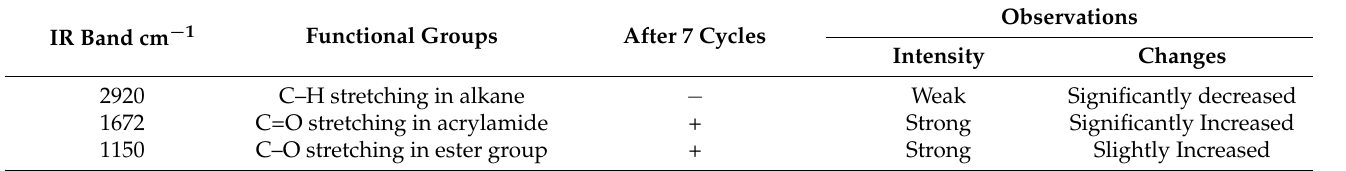
Table 3. FTIR assignments for the functional groups of C-0 and C-1 after aging test. IR Band cm − 1 Functional